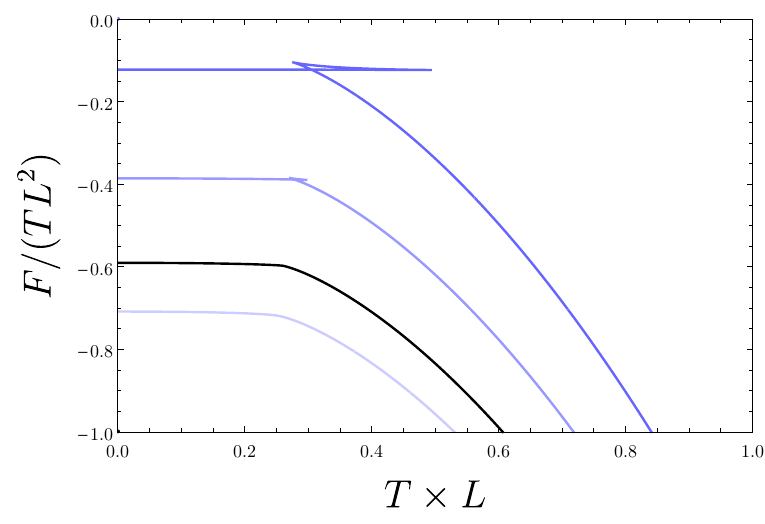
Figure 4 . Free energy in four-dimensions . Here we use an additional plot of the free energy for larger values of the coupling, using the shifted entropy. The various curves correspond to increasing magnitudes of the coupling from top to bottom. The swallowtail present on the curves shrinks, eventually terminating at a cusp for µ = L 4 / 576, which corresponds to a second-order − phase transition. For smaller larger magnitudes of the coupling, the curve is smooth with only a single